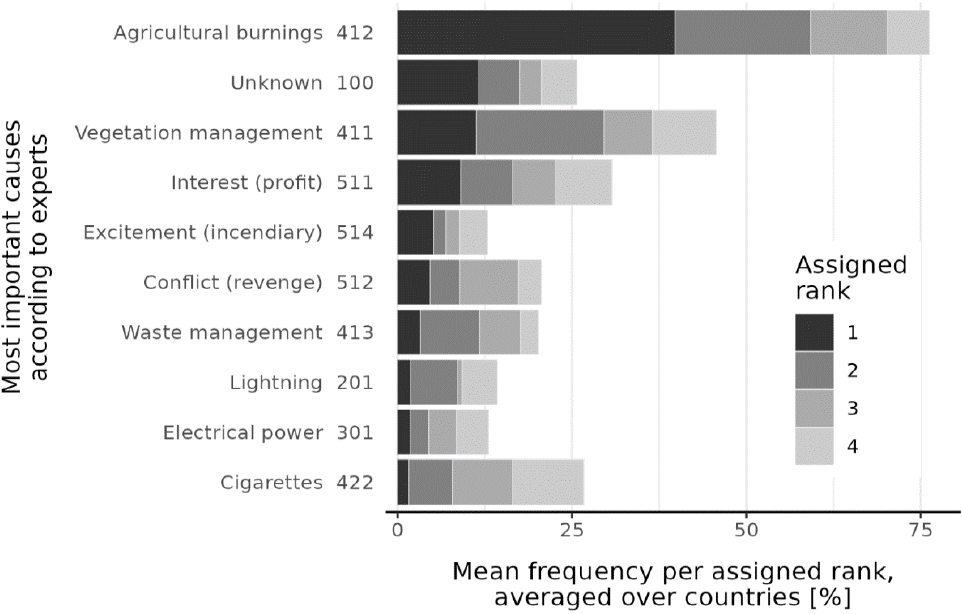
Figure 11. Bar plot of the frequencies of the most important causes identified by the experts, according to assigned importance rank (1 to 4) and averaged among the countries. Only the 10 most relevant causes are shown, ordered in decreasing importance according to the first rank frequencies (black